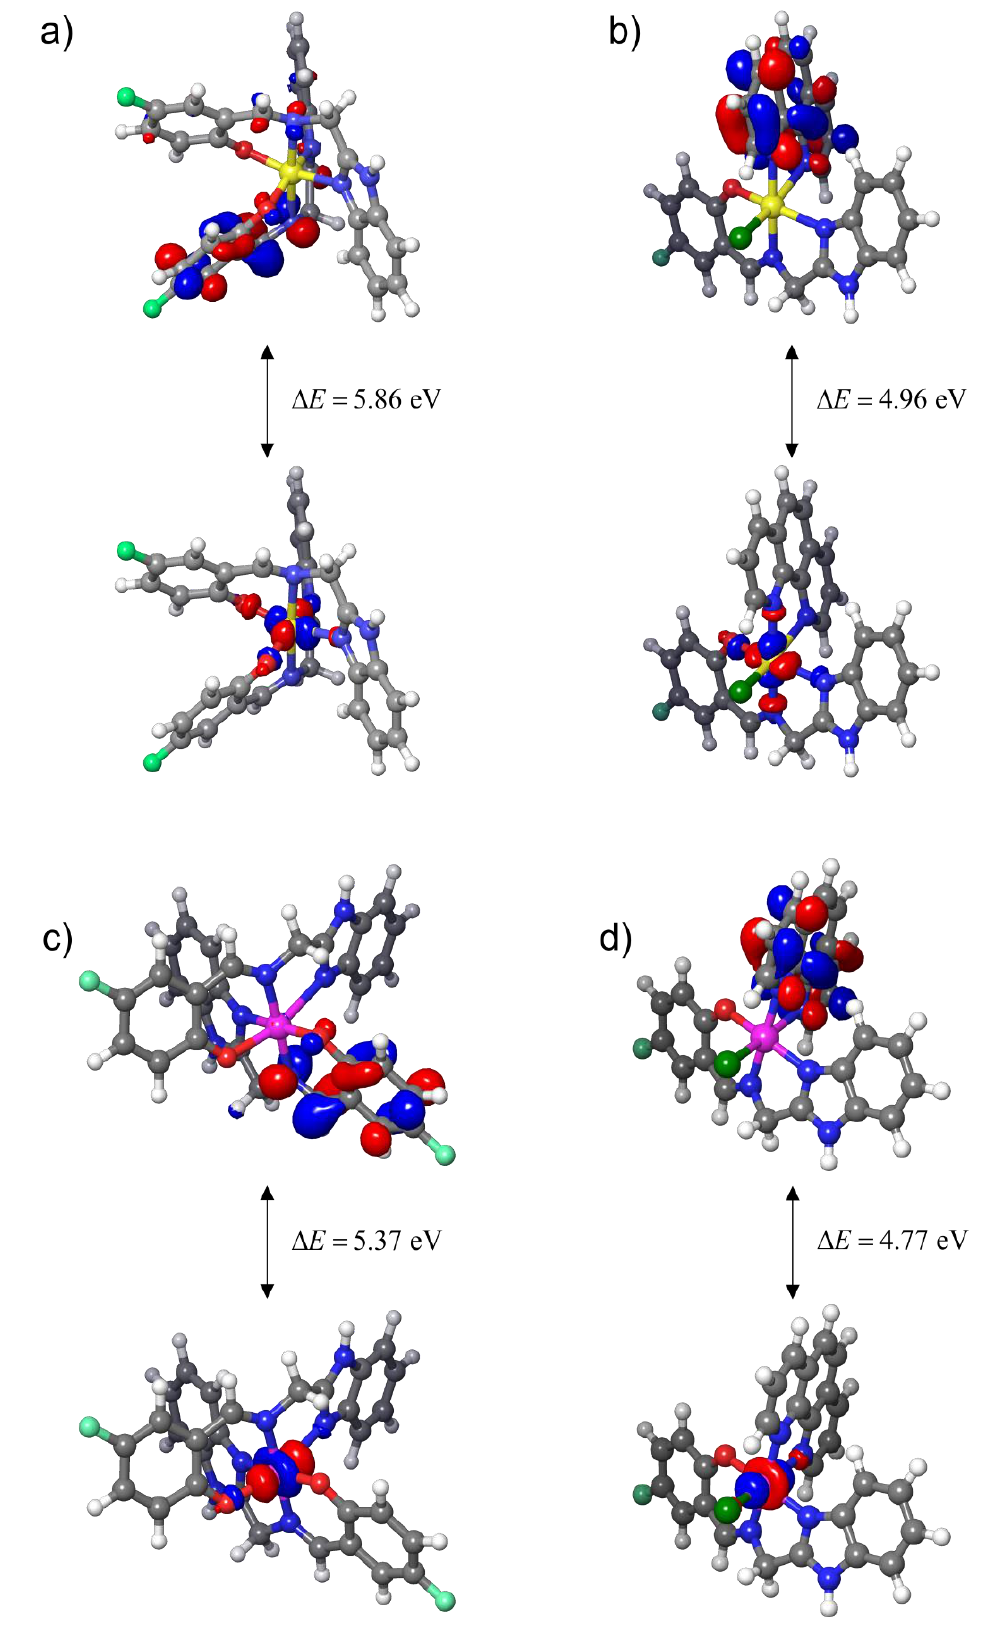
Figure 9. The FMOs of studied complexes ( a ) C1, ( b ) C2, ( c ) C3 and ( d ) C4 with corresponding HOMO-LUMO gap values Δ𝐸 . Surfaces were obtained by taking the isovalue of ±0.050 a.u.